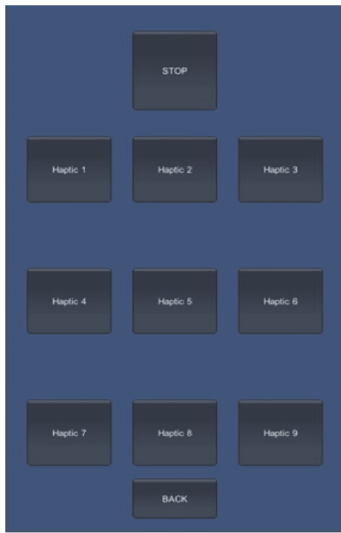
Figure 2: User interface of the experimental mobile application. (3 rhythms as shown in Figure 1), and amplitude (low- vibrating at 33% intensity, 0.3 for Audio; Mid-vibrating at 66% intensity for Haptic, 0.6 for Audio; High- vibrating at 100% intensity, 1 for